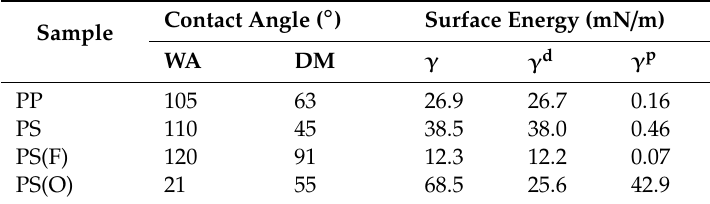
Table 3. Surface energy of di ff erent surfaces.